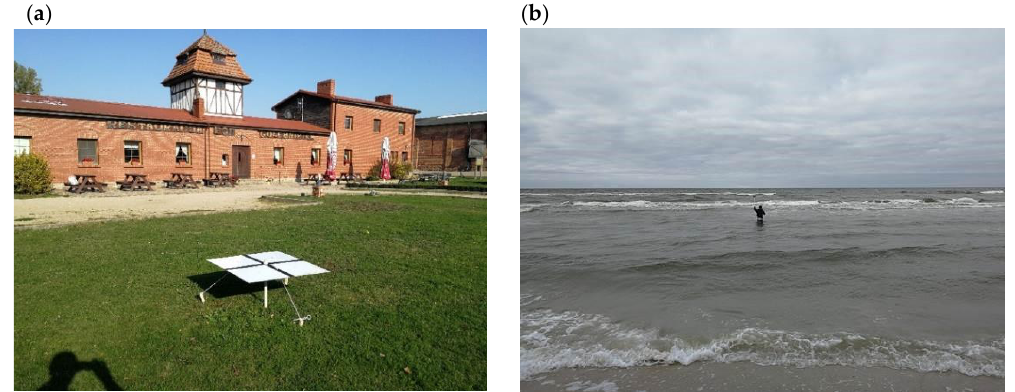
Figure 2. Surveying techniques of ( a ) control points on the measured terrain, and ( b ) manual measurement of cross-sections in water using the Real Time Kinematic (RTK) Global Navigation Satellite System (GNSS) method.